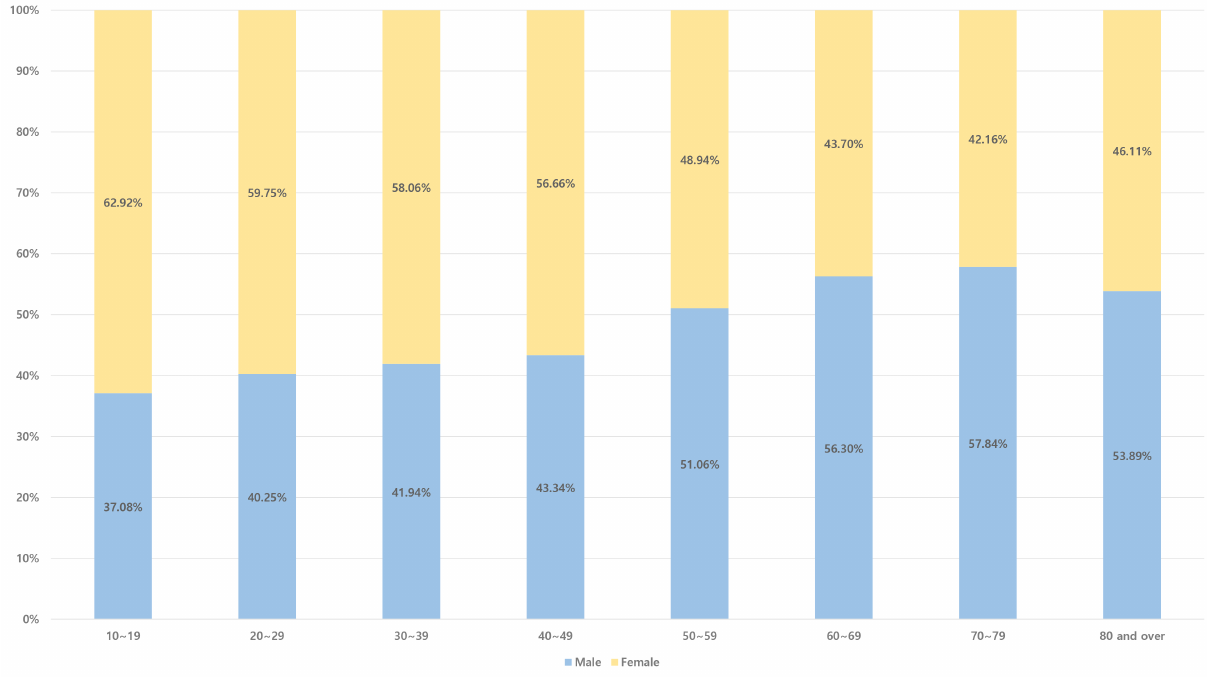
Fig. 2. Proportions of men and women in the study by age